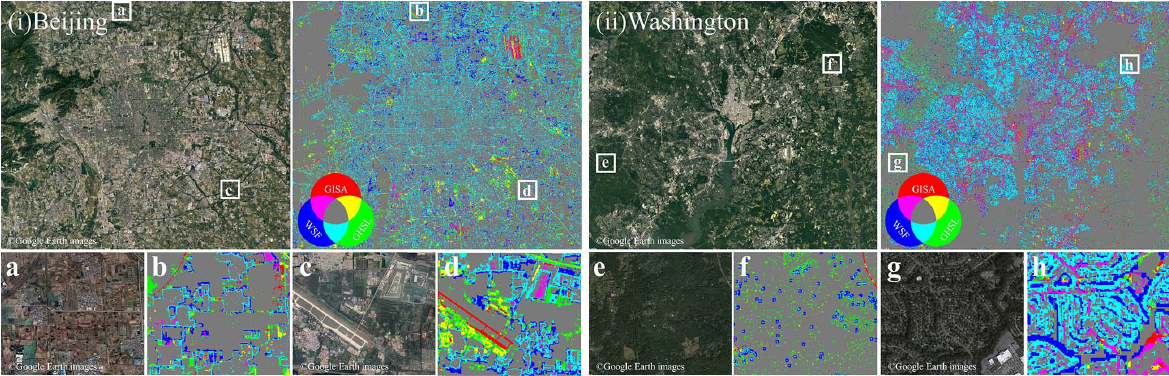
Figure 12. Illustration of WSF2015, GHSL 2018, and GISA-10m in (i) Beijing and (ii) Washington. Regions where the three datasets all agree are shown in gray.